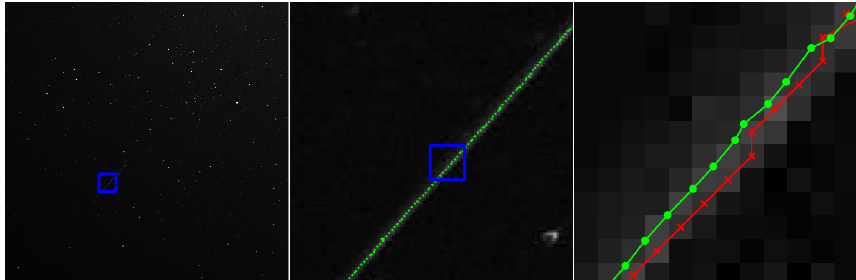
Figure 14. Inertially pointed star field image captured with with the Omnidirectional Space Situational Awareness (OmniSSA) system. This example image has a 10 s exposure time and contains a satellite that appears as a streak within the image. The red symbols denote pixel-level streak estimates and × green dots denote the refined subpixel localization estimates. The original OmniSSA image is courtesy of Dr. Marcus Holzinger of University of Colorado